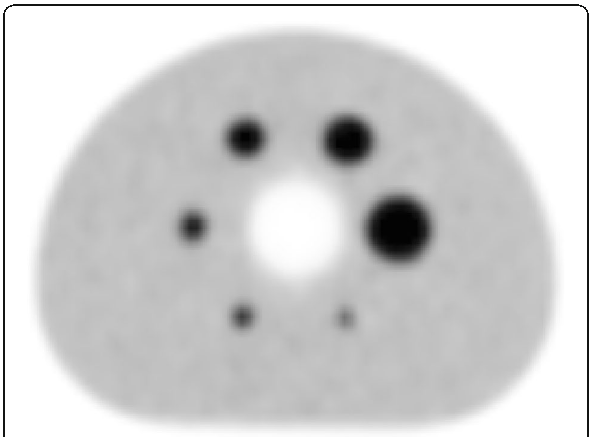
Fig. 6 Central slice of the image quality phantom. The TBR was